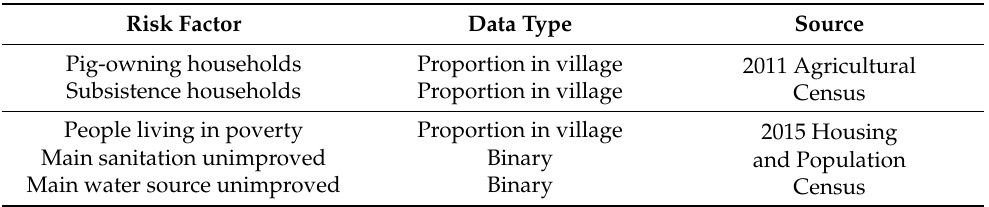
Table 1. Risk factor